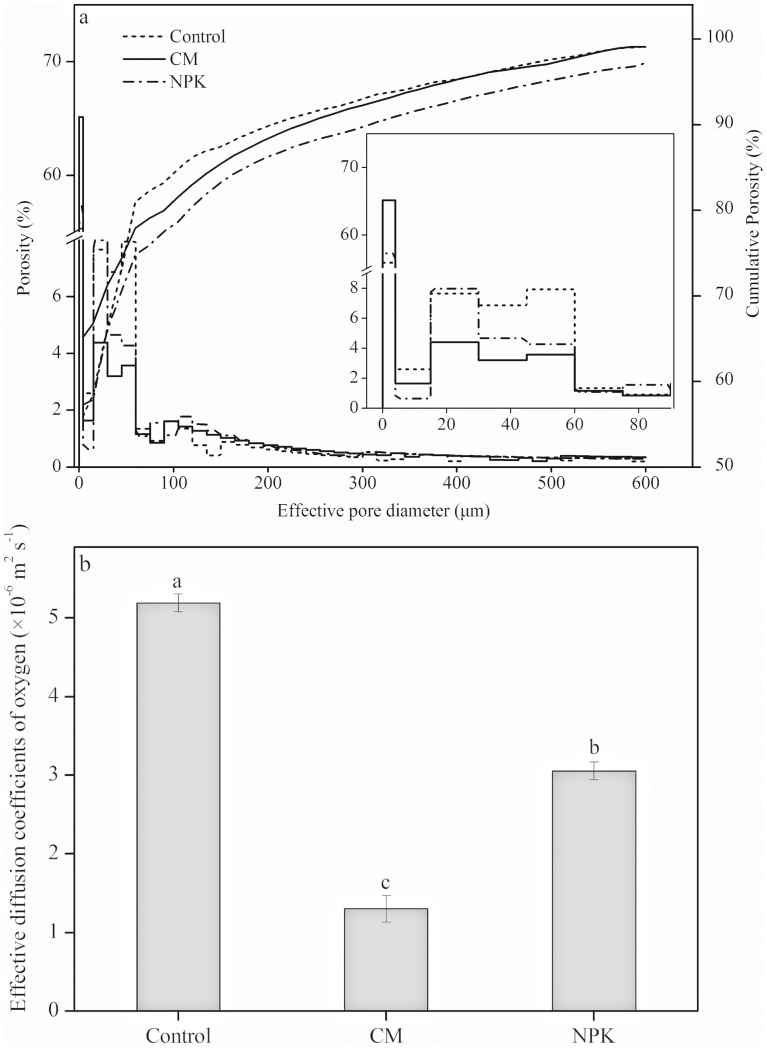
Effect of long–term applications of fertilizer NPK and compost on the proportions of pore volumes of different diameter (a) and effective diffusion coefficient of oxygen (b) in the soil.Vertical bars indicate the standard error of the means (n = 4). Different lowercase letters denote significant differences between treatments at P<0.05.